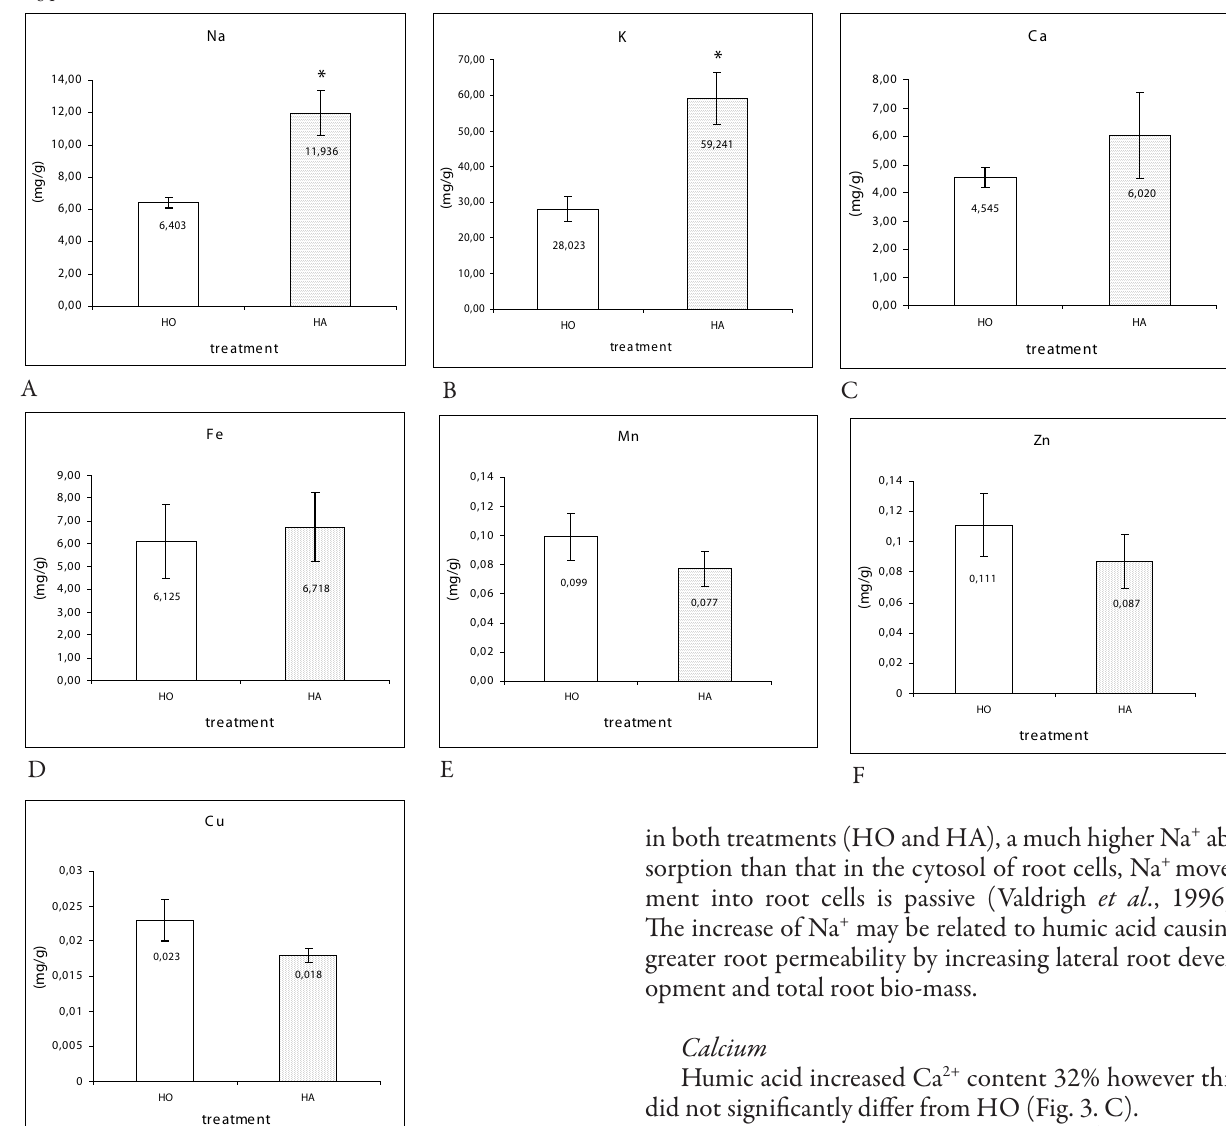
Fig. 3 Flame and atomic absorption spectrophotometer determi- nation of nutrient composition of Vicia faba L. roots. * : Signifi- cantly different from